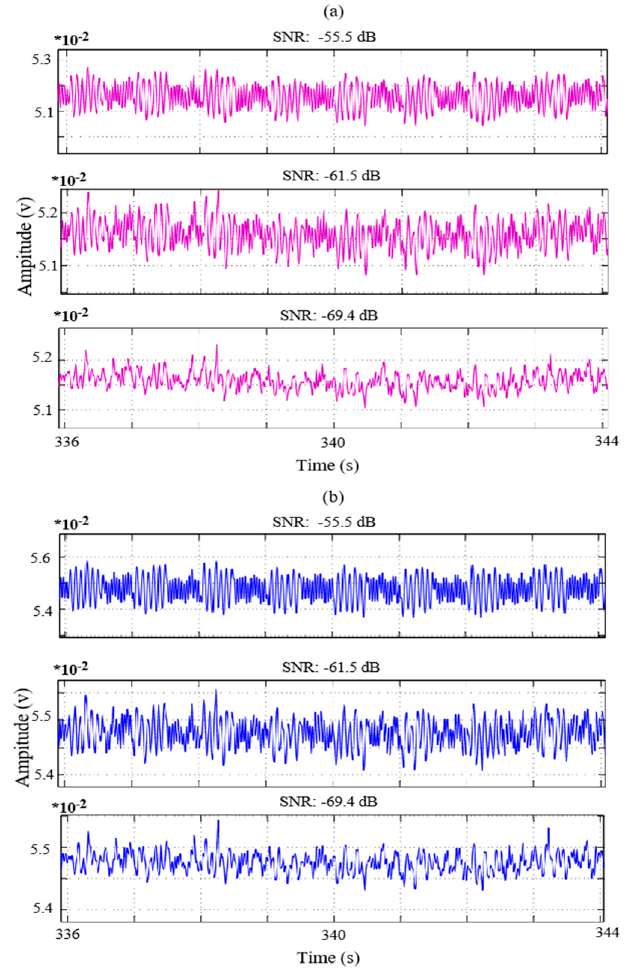
Figure 17. Comparison of pseudo-synthetic telemetry processing results for time range 336 to 346 s. The main signal SNR was varied between − 55 dB and 69.4 dB. The results were obtained by using multi-channel noise cancellation techniques: ( a ) regularized variable step-size LMS (RVSSLMS) technique; and ( b ) regularized sigmoid variable step-size LMS (RSVSLMS) technique.